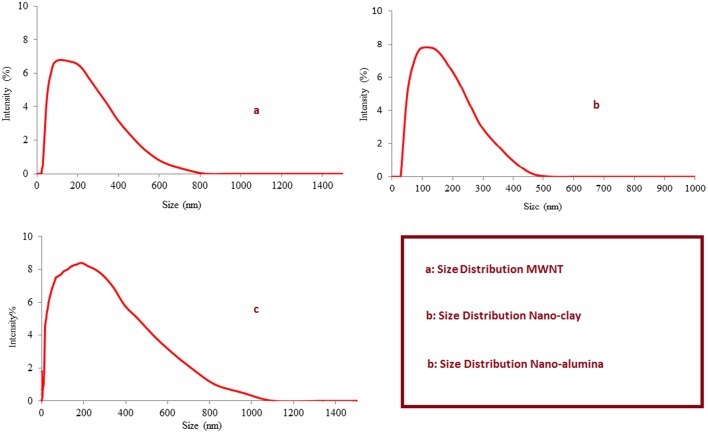
Size distributions of MWNT (a), nano-clay (b), nano-alumina (c).